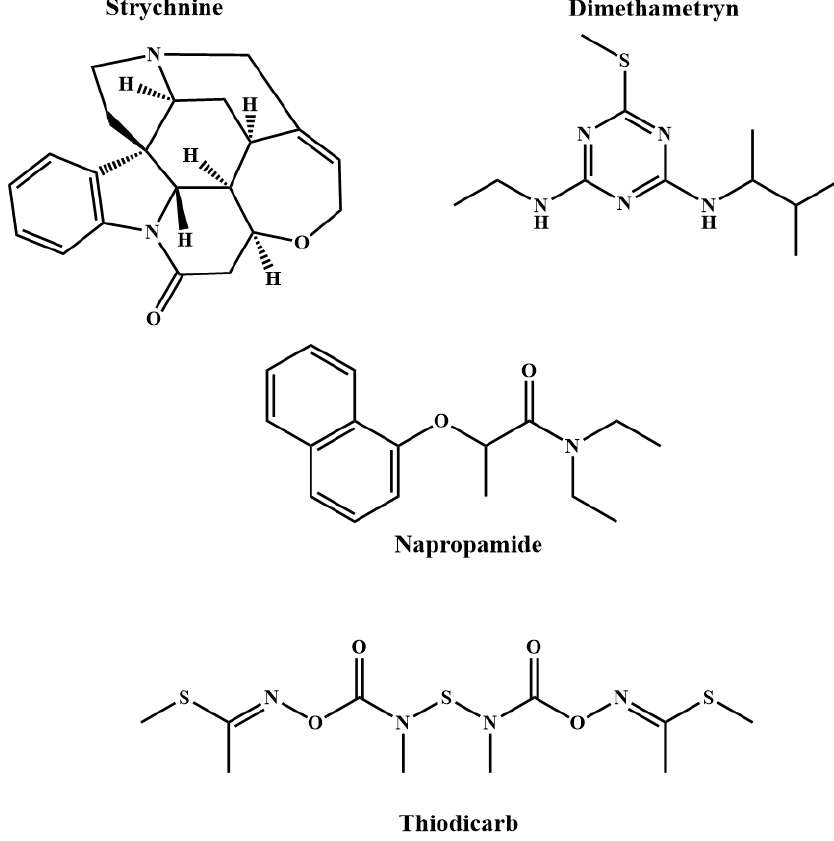
Figure 1. The chemical structures of the studied poisons.